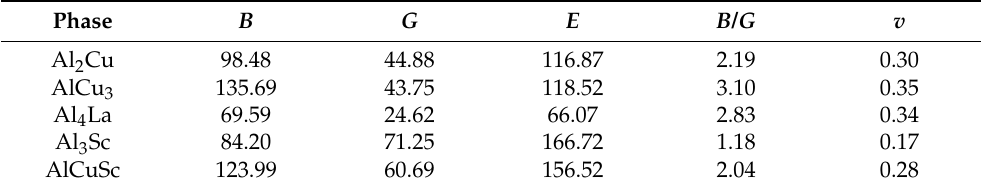
Table 4. Bulk modulus B (GPa), shear modulus G (GPa), Young’s modulus E (GPa), G/B and Poisson’s ratio v of intermetallic